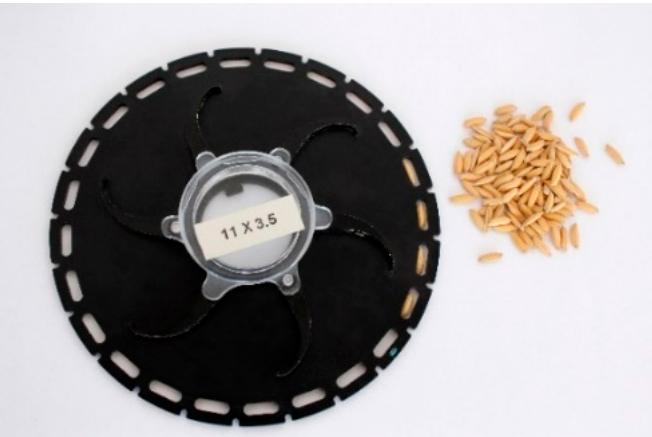
Figure 3. Singulation disc with cavity size of 11 × 3.5 mm.